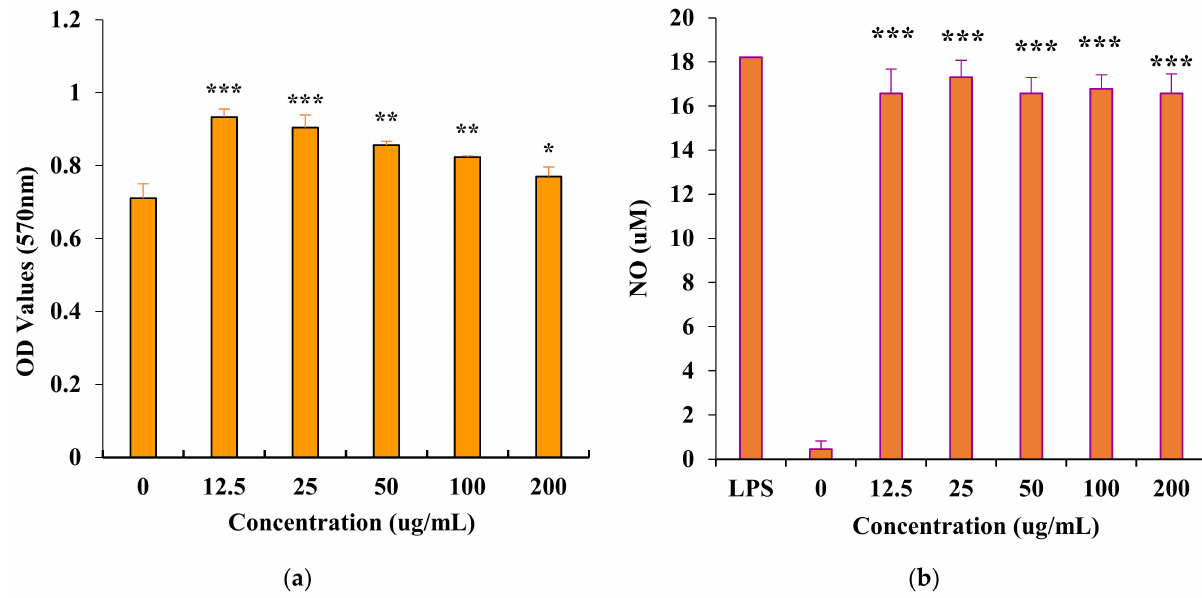
Figure 8. Effects of PAP-3 on the proliferation of RAW264.7 cells ( a ) and on nitric oxide (NO) production in RAW264.7 cells ( b ). (The values are presented as means ± SD ( n = 4). Significant differences were designated as * p < 0.05, ** p < 0.01, *** p < 0.001. LPS: Positive Control).